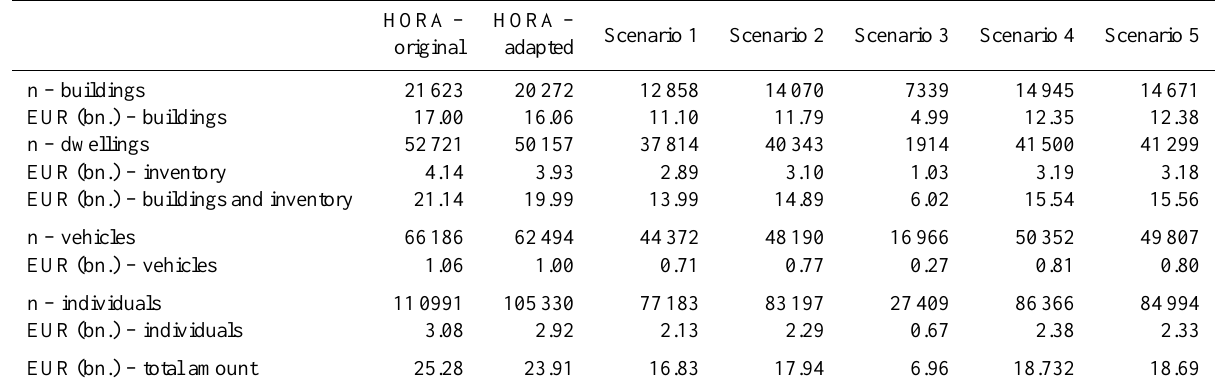
Table 3. Elements at risk and damage potentials for the general hazard areas (original and adapted HORA flood areas) and the different considered scenarios.